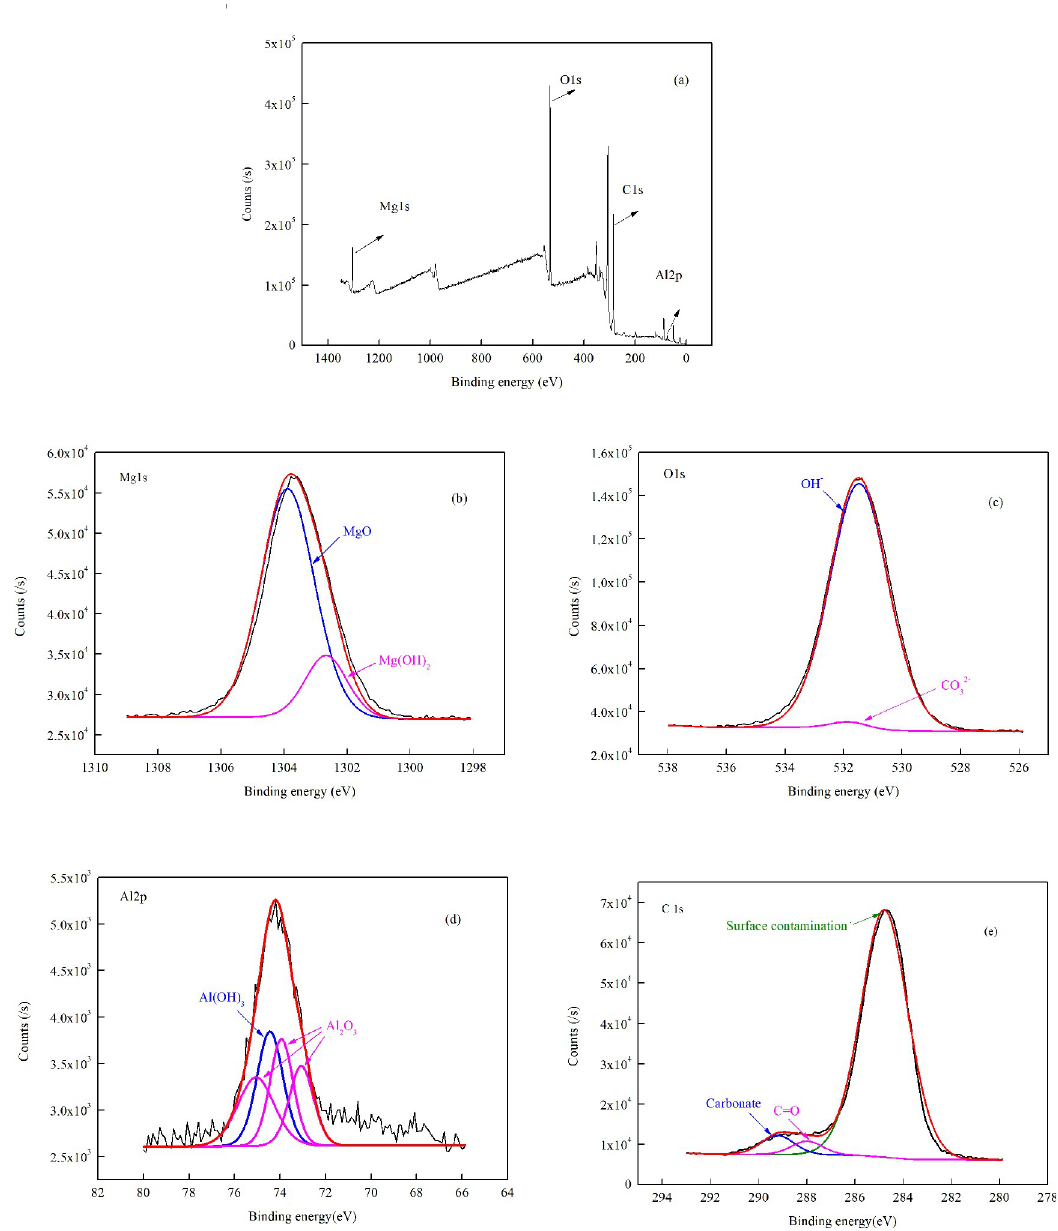
Fig 9. XPS analysis of corrosion products after exposure under TEL for 12 h. (a) general diagram, (b) Mg 1 s, (c) O 1s, (d) Al 2p, (e) C 1s.